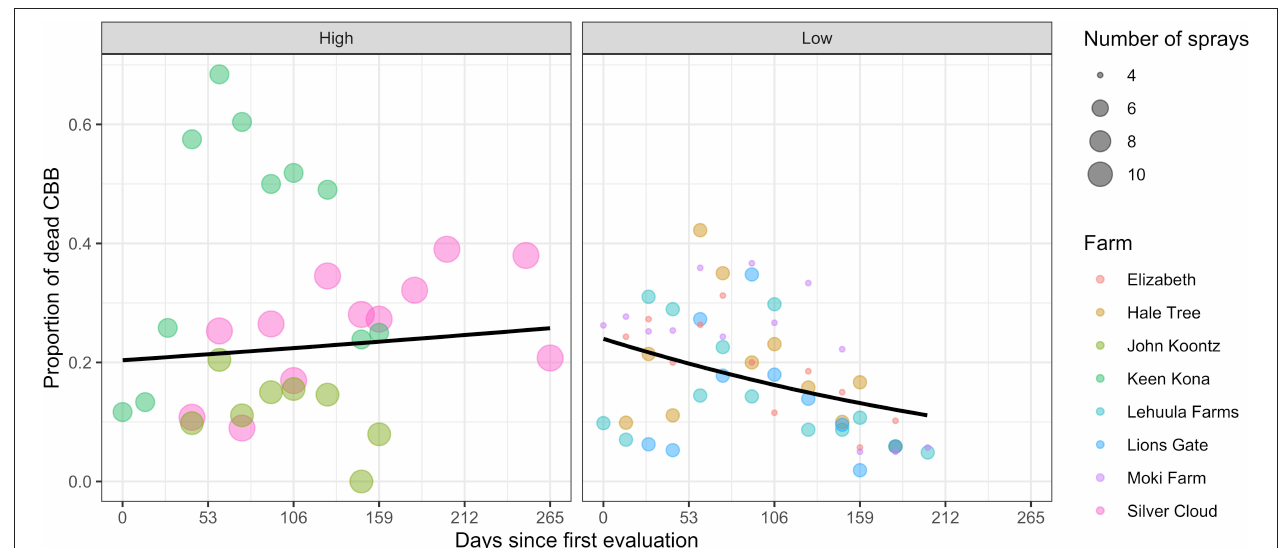
FIGURE 6 | Overall CBB mortality from coffee farms in the Kona and Ka’u districts of Hawaii adopting calendar (high) and threshold (low) spray programs. Data points represent the proportion of CBB mortality for each sample date. Curves are the fitted means obtained using generalized binomial mixed models with linear and quadratic random effects over time.